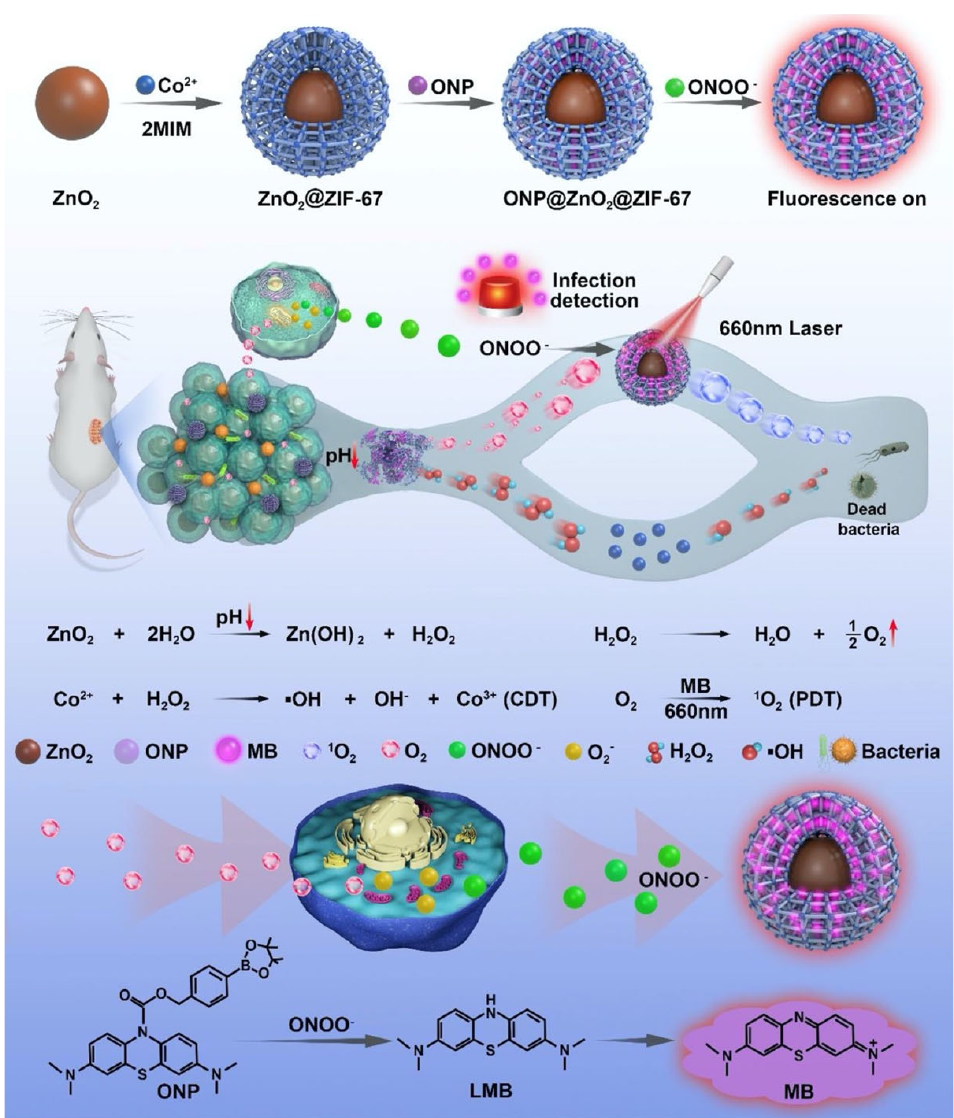
Figure 16. Scheme showing preparation of ONP@ZnO 2 @ZIF ‐ 67 and the PDT ‐ and CDT ‐ induced mechanism of antibacterial action for the material, showing the ZnO core coated with ONP ‐ loaded ZIF ‐ 8 MOFs. Upon being exposed to ONOO − , MB would be generated from ONP, hence exhibiting fluorescence. MB generation can be used as a marker for infection sites for detection, as a result of the over expression of ONOO − and low pH at infection sites. When irradiated, the nanoparticles exhibit antibacterial properties as a result of ROS generation. Reproduced with permission from [110] .